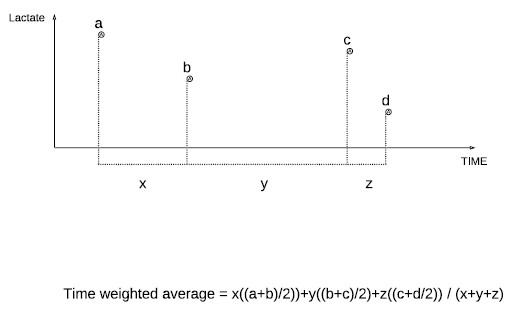
Diagram describing the calculation of time weighted lactate (LacTW).